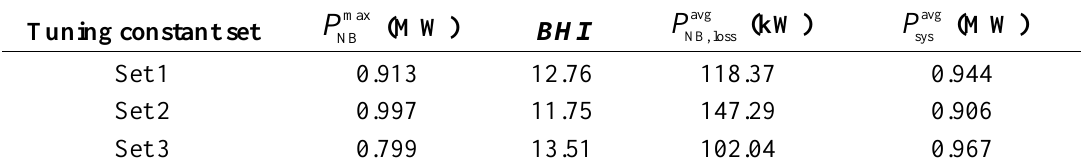
Table 6. Impact of tuning constant to system